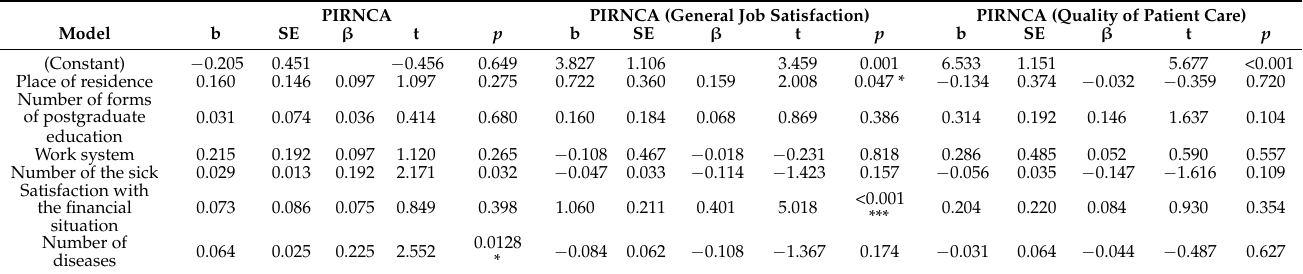
Table 5. Regression analysis of the impact of sociodemographic characteristics on the rationing of nursing care, overall job satisfaction, the quality of patient care. PIRNCA PIRNCA (General Job